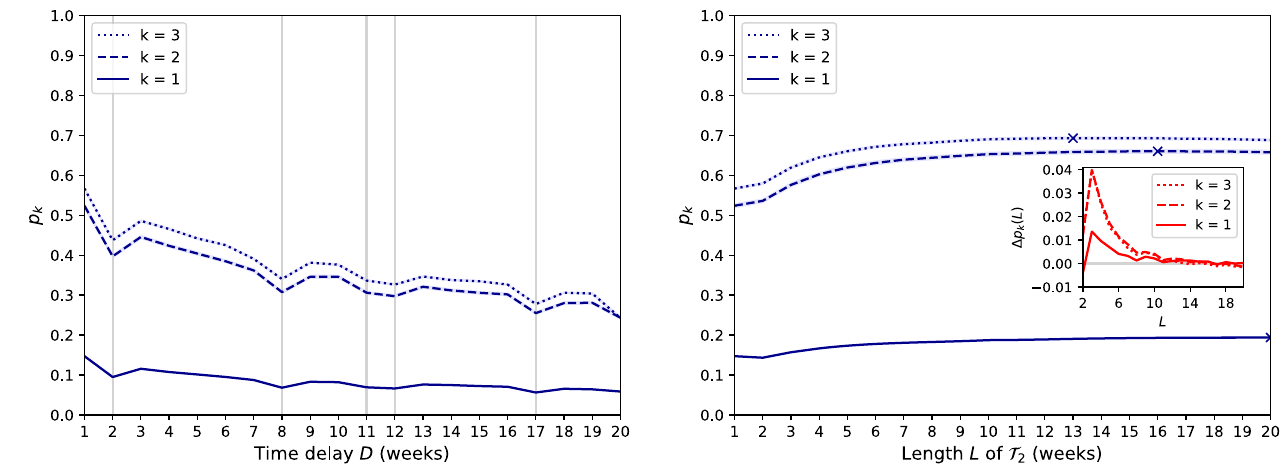
Fig. 3 Probability of identi fi cation when the time delay increases. We plot Fig. 4 Probability of identi fi cation for increasing time period length of p k , the probability of identi fi cation within rank 1 for k ∈ {1, 2, 3} when the auxiliary data. For each k ∈ {1, 2, 3}, we plot p k , the probability of correct time delay between the dataset and the attacker ’ s auxiliary information is identi fi cation ( R = 1) when the attacker ’ s auxiliary data T 2 consist of L equal to D weeks. The auxiliary information is one week long. The 95% weeks, 1 ≤ L ≤ 20 (the largest value for each k is marked). The 95% con fi dence interval is shown in light blue. The vertical gray lines correspond con fi dence interval is shown in light blue. (Inset) shows the difference to holidays. While p k decreases slowly with the time delay, our model quotient Δ p k ( L ) = p k ( L ) − p k ( L − 1) for 2 ≤ L ≤ 20. The probability of correct correctly identi fi es people p k = 2 = 24.3% of the time even after 20 weeks identi fi cation increases fast before plateauing around L = 8 weeks for all ( k = 2). Even for k = 1, the probability after 20 weeks is as high as values of k , even slightly decreasing after L = 16 and L = 15 for k = 2 and p k = = 5.8%. The probability of identi fi cation decreases as y = p k ( D = 1) k = 3, respectively. The largest values are p k = = 19.4% at L = 20, 1 1 − α D − 1), with α = − 0.006, α = − 0.017 and α = − p = 66.0% at L = 16, and p = 69.3% at L = 13. This shows that having k × ( k = 2 k = 3 1 2 3 more auxiliary data further improves the performance of the attack, although data that are more distant in time seem less useful than closer ones, even slightly detrimental.